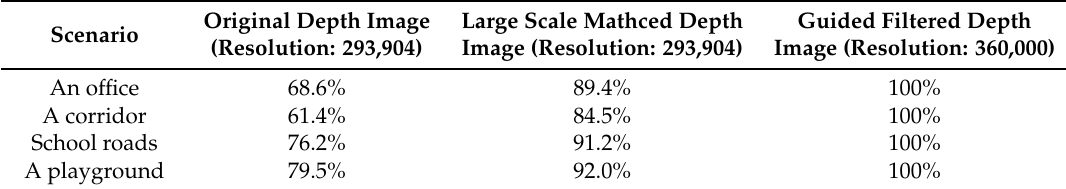
Table 2. Average density of depth images including the original depth image, large-scale matched depth image and guided-filtered depth